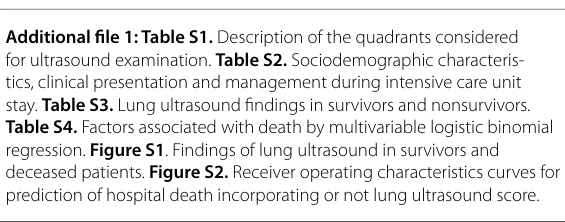
Table S4. Factors associated with death by multivariable logistic binomial regression. Figure S1 . Findings of lung ultrasound in survivors